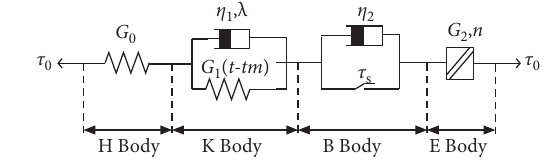
Figure 11: Creep fatigue